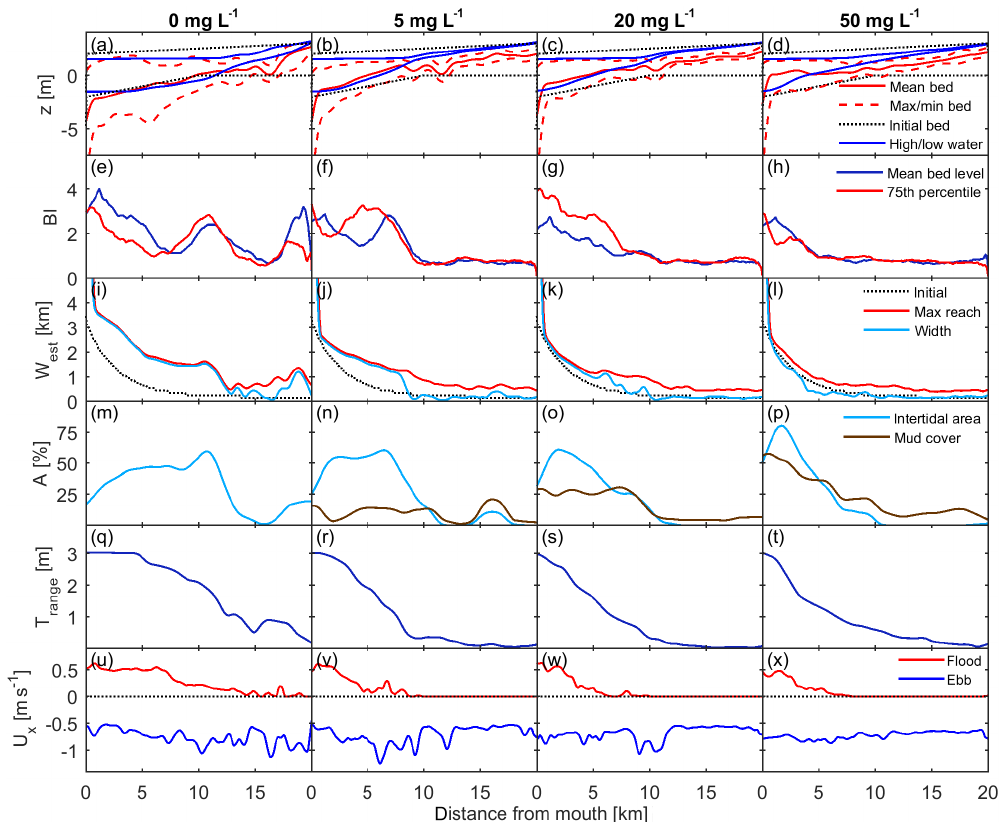
Figure 8. Hydrodynamics and morphology along estuaries with different mud supply concentrations after 2000 years. From left to right (columns): model with only sand (03) and mud supply concentrations of 5 (10), 20 (default, 01) and 50mgL − 1 (09). (a–d) Minimum, mean and maximum bed elevation, high and low water level and minimum and maximum initial bed level, (e–h) braiding index and (i–l) estuary width defined as the initial width, maximum reach over the whole scenario run, the width of wet cells in the model, width defined by a threshold value that is used to mask the cells that are around the dry–wet cell threshold. (m–p) Intertidal area and mud cover as a percentage of the total area, (q–t) tidal range and (u–x) peak ebb and flood